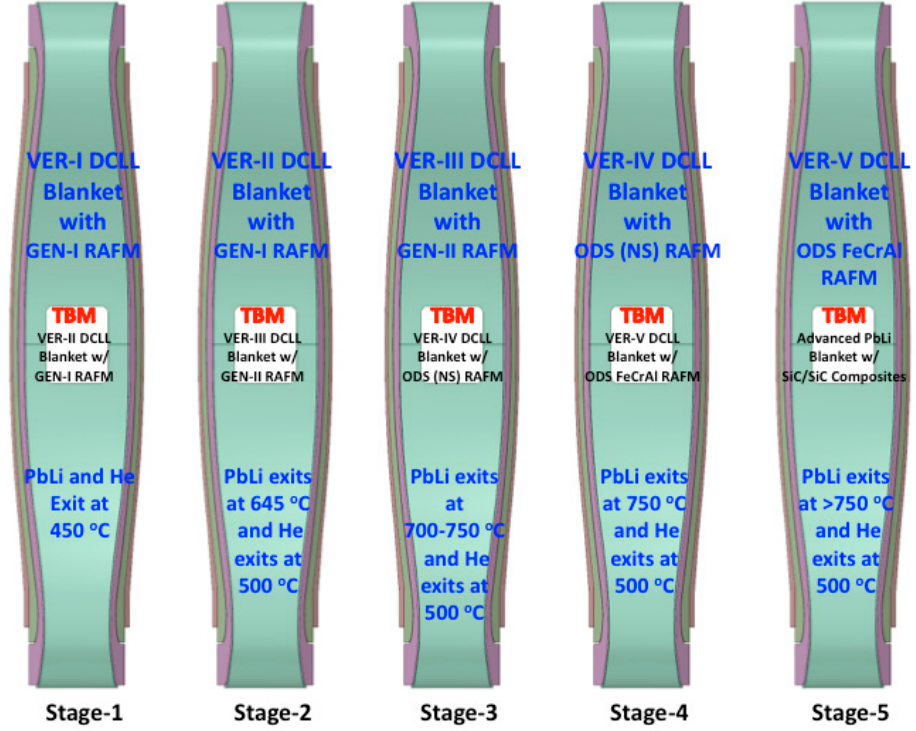
Figure 6. Advancement of blanket testing and deployment of new versions of the DCLL blanket in subsequent phases of FNSF.